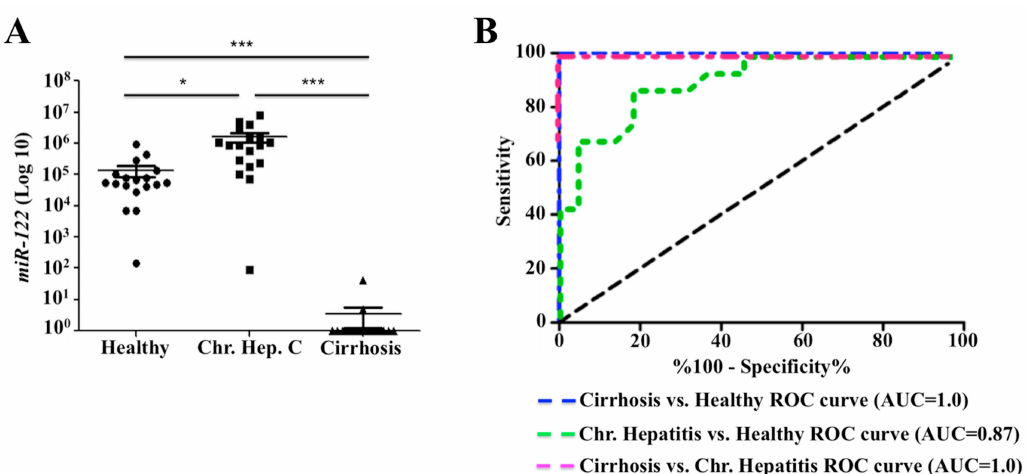
Figure 8. Serum miR-122 levels discriminating patients with hepatitis C virus (HCV) infection and cirrhosis from healthy controls. ( A ) Copy number variation of serum miR-122 levels between healthy, chronic HCV and chronic HCV with cirrhosis. ( B ) Receiver Operating Characteristic (ROC) plot. Data shown in panel A was used to generate ROC plot for determining diagnostic value of serum miR-122 of cirrhosis and chronic HCV patients from healthy controls. The results are expressed as the mean ± standard error of mean (SEM). Error bars represent SEM. p -values were calculated by ANOVA between di ff erent groups. * p - value < 0.05, *** p -value <